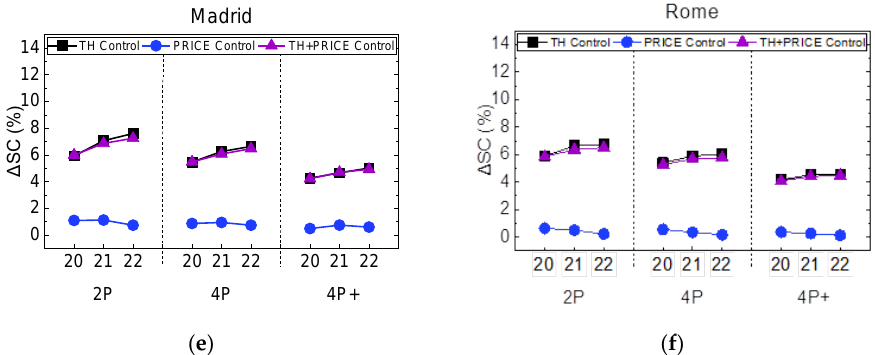
Figure 8. Change in self-consumption (ΔSC) due to the advanced control algorithms for the small PV system with battery for the full range of boundary conditions: country, appliance use (2P, 4P, and 4P+) and room set temperature (20, 21, and 22 °C). ( a )–( f ) shows the ΔSC respectively for each of the six examined locations.